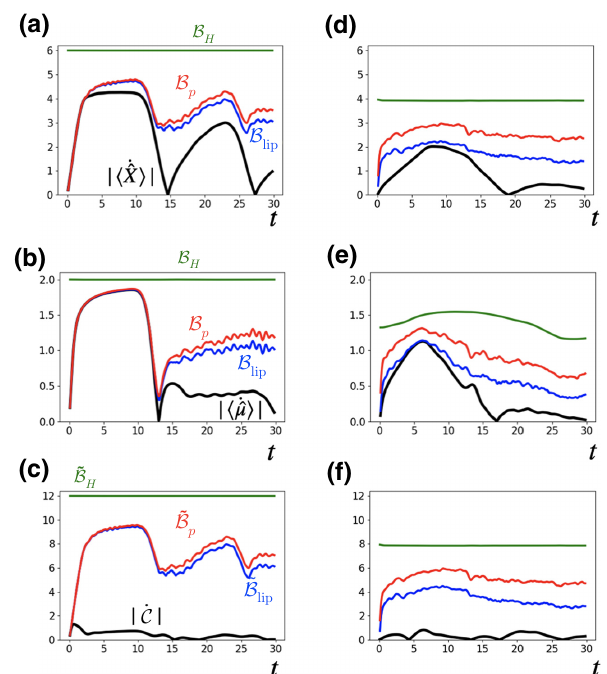
FIG. 9. Verification of the speed limits for systems with mul- tiple hardcore bosons from the initial state (a),(c),(e) | (cid:13) 1 (cid:4) or (b),(d),(f) | (cid:13) 3 (cid:4) . (a),(b) Speed of the sum of the positions of the ˙ˆ particles, (cid:3) X (cid:4) (black), and the speed limits given by B Lip in Eq. (42) (blue), B p in Eq. (45) (red), and B H in Eq. (48) (green). systems. (c),(d) Speed of the position of the rightmost parti- ˙ˆ μ (cid:4) cle, (cid:3) (black), and our speed limits. Remarkably, the bounds B B (cid:3) 12 from | (cid:13) (cid:4) , for Lip and 1 p can provide good bounds for t ˙ˆ μ (cid:4)| which |(cid:3) exhibits nonmonotonic behavior. (e),(f) Speed of the ˙ C | (black) and the speed limits given by macroscopic coherence | ˜ B ˜ B ˜ B Lip in Eq. (81) (blue), and p (red) and H (green) in Eq. (54). We use K = 1, V = 0.1, W l = 0, L = 24, and M =